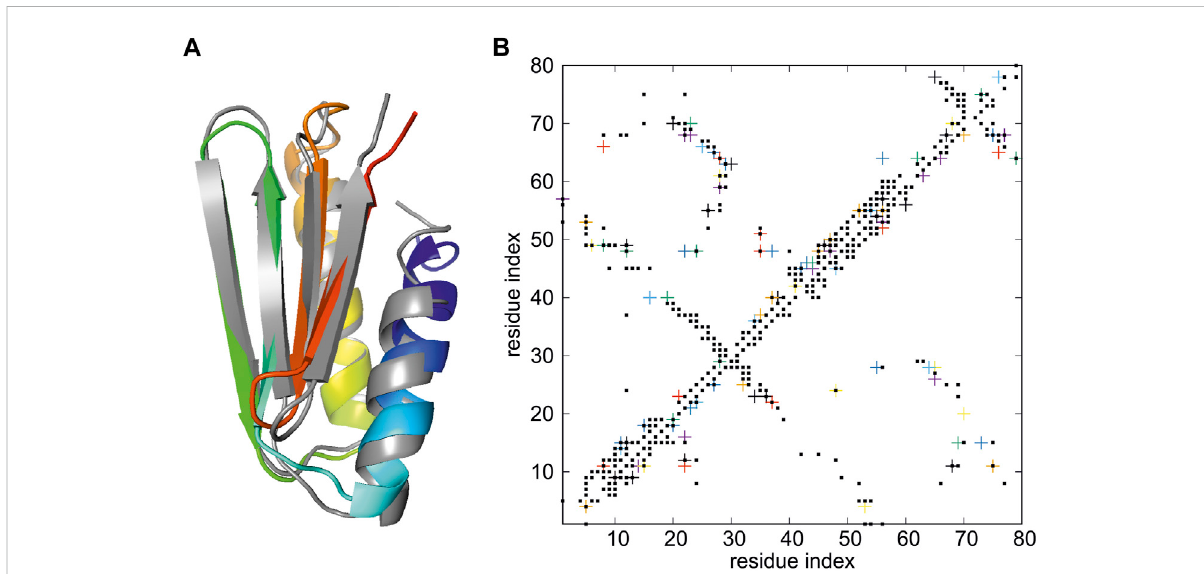
FIGURE 3 (A) Superposition of the model 1 of the structure of de novo designed Foldit3 protein (PDB: 6msp) simulated with NMR-data-assisted UNRES, usingtheexpert-editedrestraintsdepositedatthe6mspPDBentry(gray)andtheexperimentalstructure(coloredfrombluetoredfromtheN-tothe C-terminus). The RMSD and GDT_TS values are 2.03 Å and GDT_TS of 76.88, respectively. (B) The proton-proton contacts in the calculated structures (black squares) superposed on those found from NMR experiments (colored crosses).